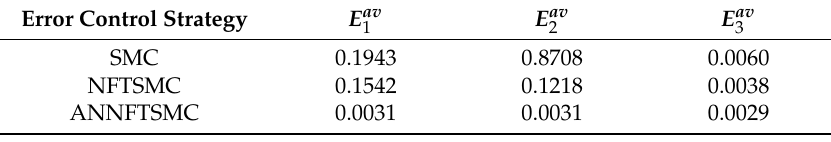
Table 2. The averaged tracking errors under control input signals of the control strategy.